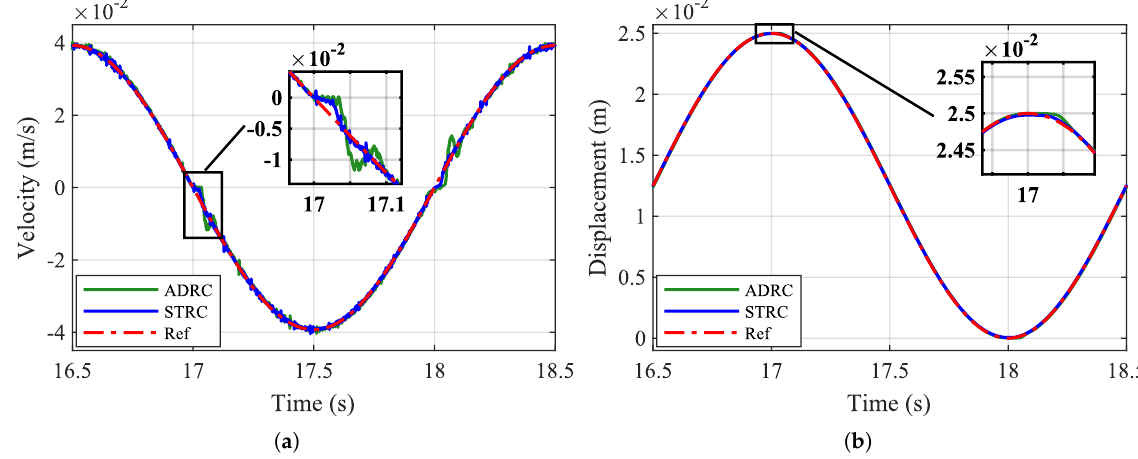
Figure 15. Experimental waveform comparison at 0.5 Hz. ( a ) Velocity; ( b ) displacement.